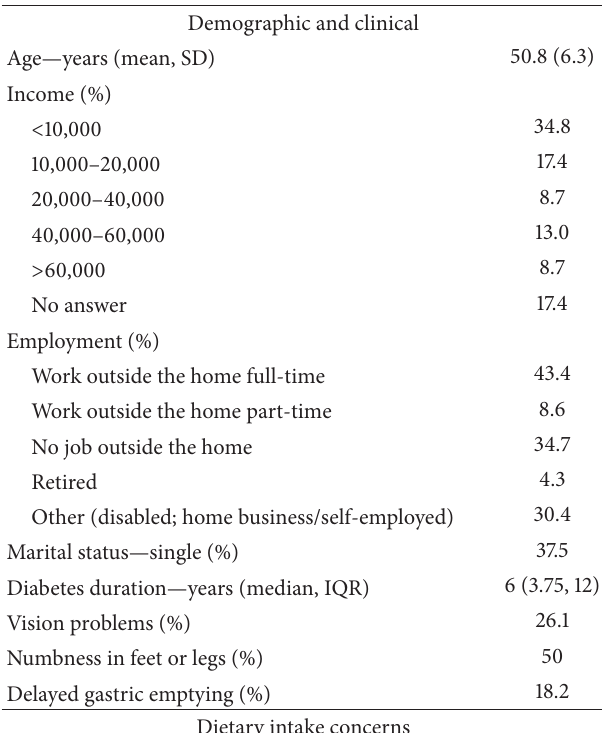
Table 2: Baseline participant characteristics ( 𝑁 = 24